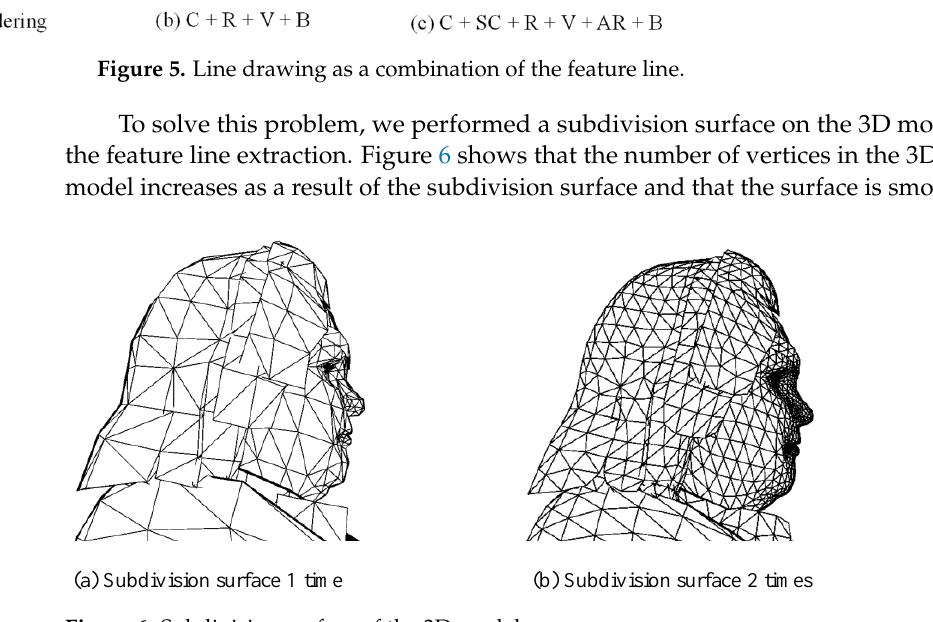
Figure 6. Subdivision surface of the 3D model.